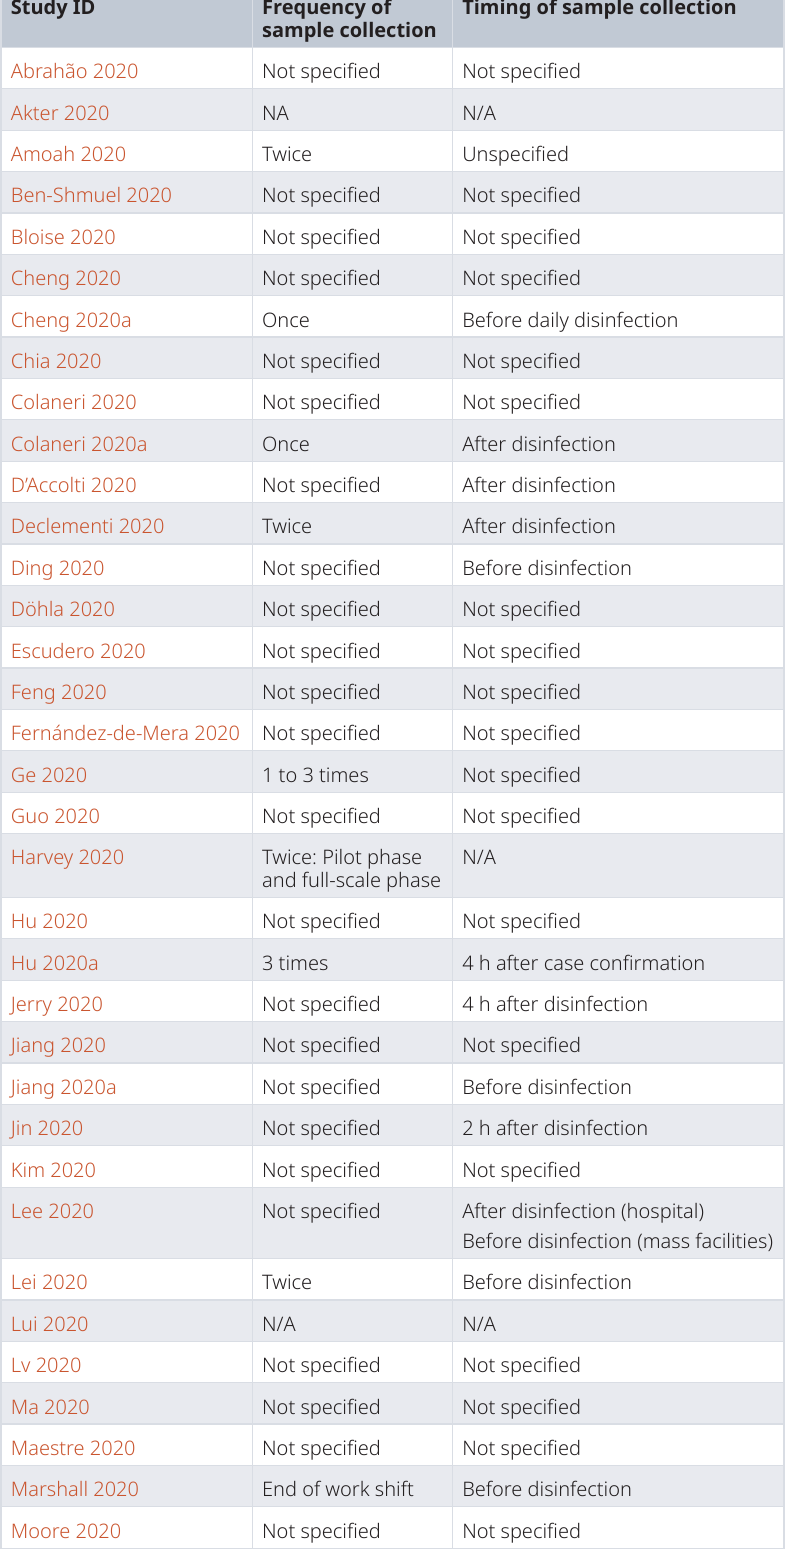
Table 3. Studies sample collection